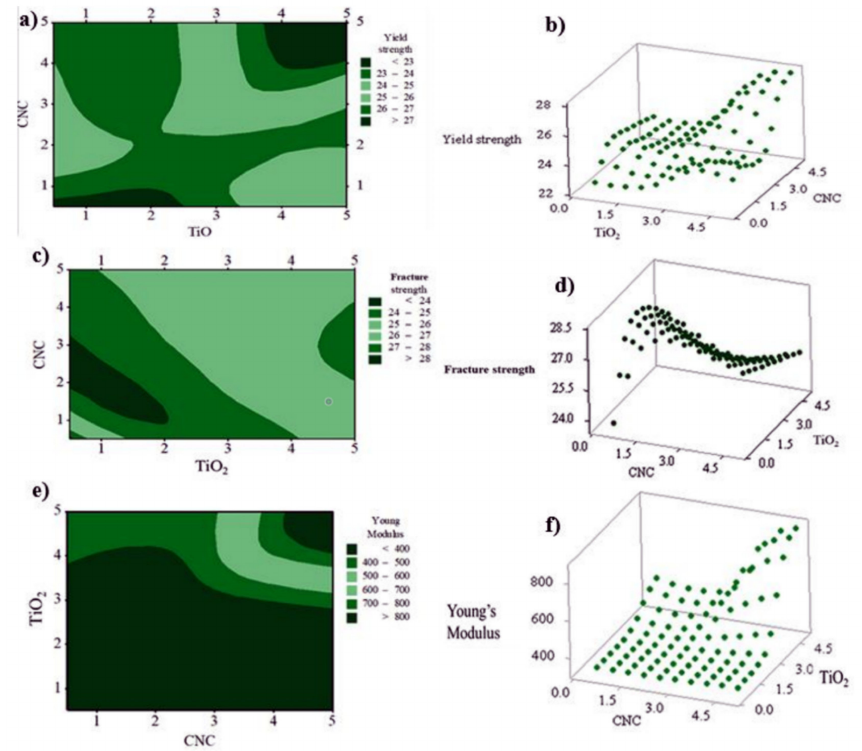
Figure 17. Scatter and contour plots for multi-optimized responses (fracture strength ( a , b ), yield strength ( c , d ), and young’s modulus ( e , f )) of the developed HDPE nanobiocomposites modeled by ANN-GA